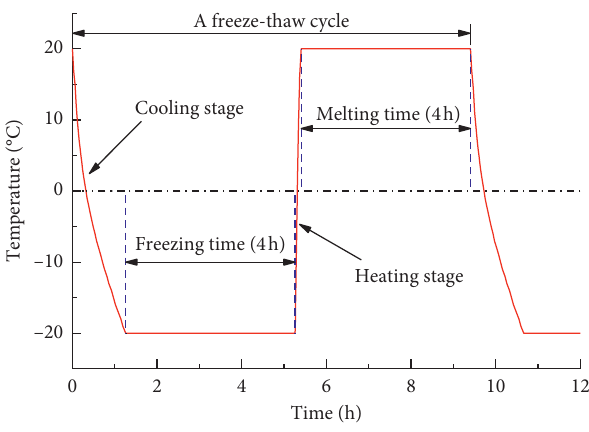
Figure 2: Cycle temperature and time.